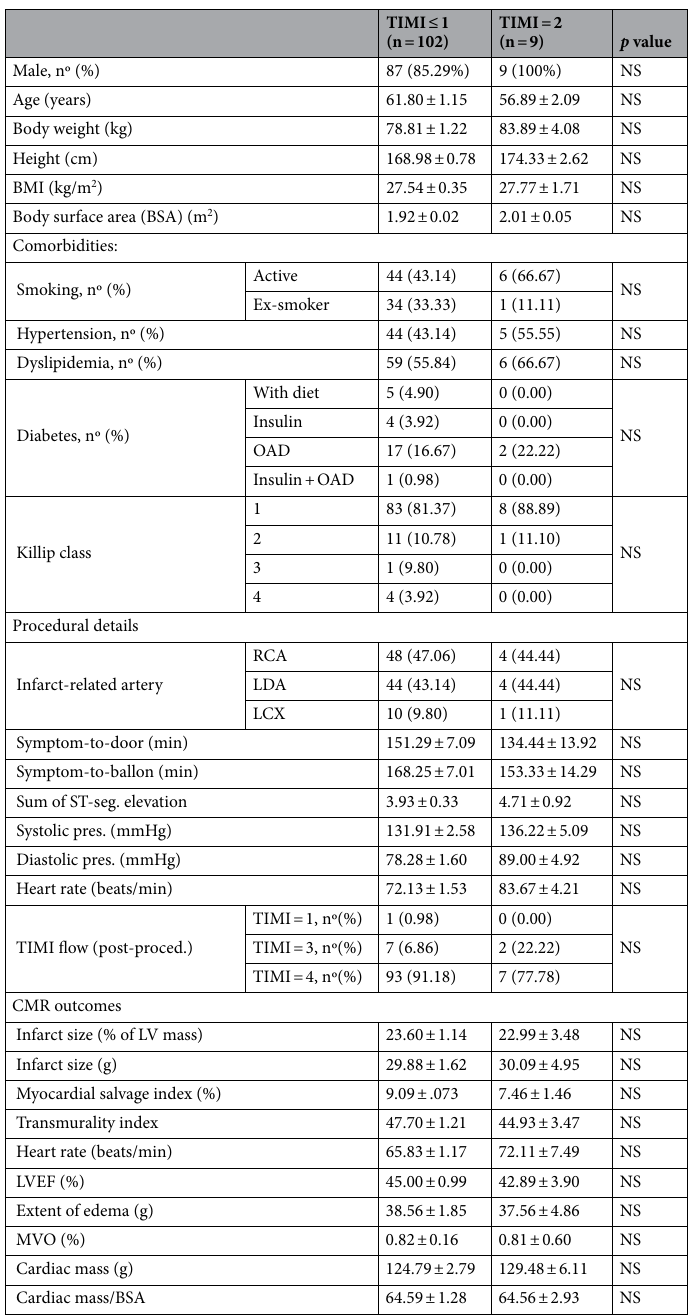
Table 1. Baseline clinical and procedural characteristics, comorbidities and CMR outcomes of patients with initial TIMI flow ≤ 1 versus those with TIMI flow at admission equal to 2. BMI, body mass index; BSA, body surface area; LCX, left circumflex coronary artery; LDA, left descending coronary artery; LV, left ventricular; LVEF, left ventricular ejection fraction; MVO, relative microvascular obstruction; OAD, oral antidiabetic drugs; pres., pressure; post-proced., post-procedure; RCA, right coronary artery; seg.,